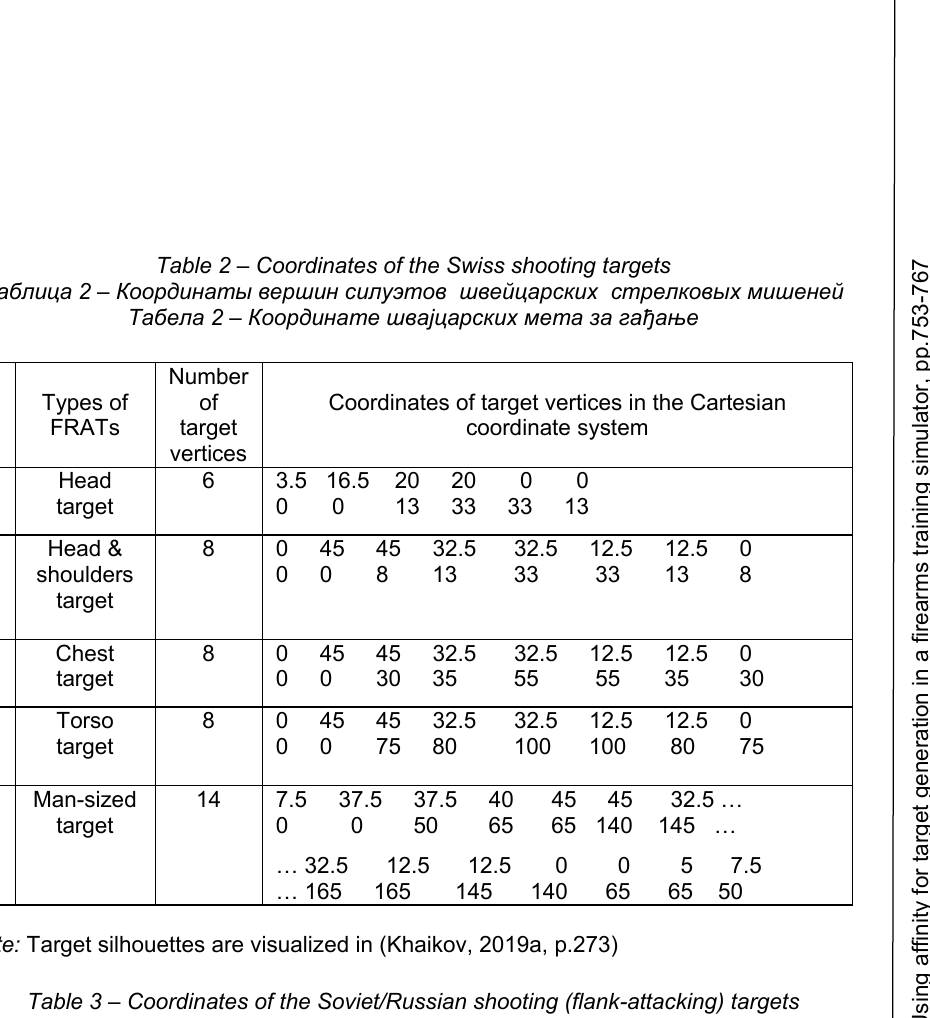
Table 3 – Coordinates of the Soviet/Russian shooting (flank-attacking) targets Таблица 3 – Координаты советских / российских стрелковых Табела 3 – Координате совјетских / руских ( бочних ) мета за